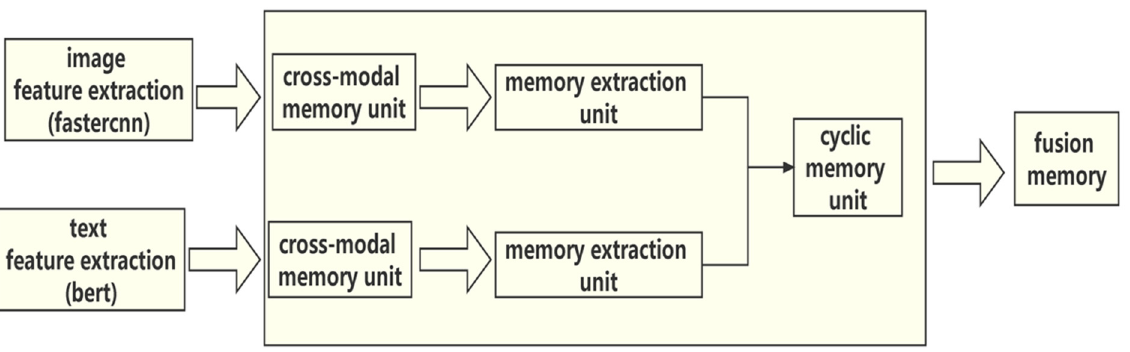
Figure 3. The step-by-step process of how image features and text features are fused, which is an important part of multimodal encoders.